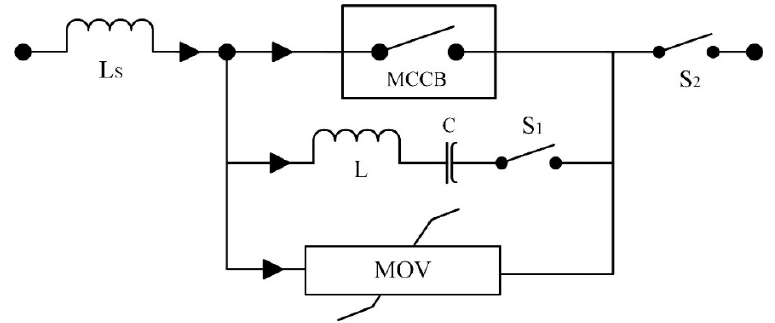
Figure 12. Active resonance MCCB configuration [71].